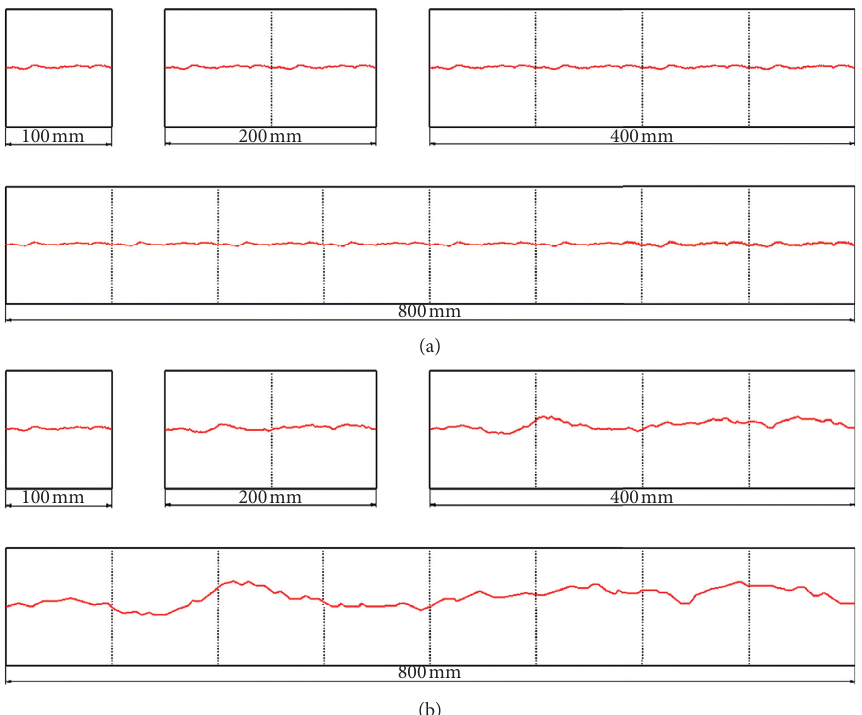
Figure 7: Geometry design of numerical joints in PFC2D: (a) repeated and (b) enlarged rock joints derived from the tenth standard JRC